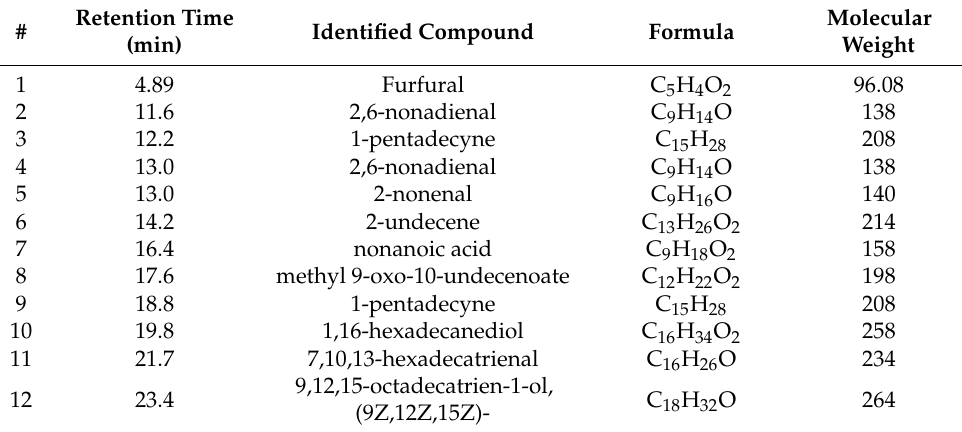
Table 1. Identification of main fraction compounds of the essential oil samples extracted from cucumbers by VMHD.